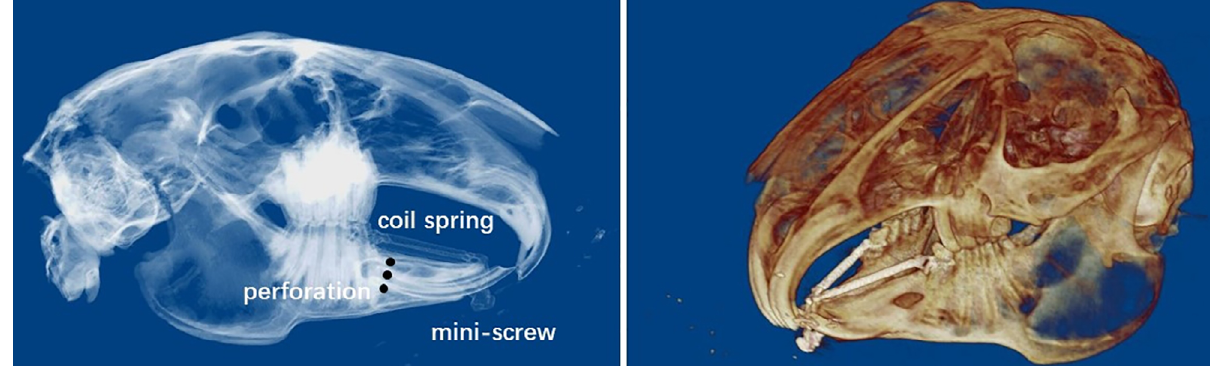
Figure 1- Osteoperforation-assisted tooth movement in rabbit models